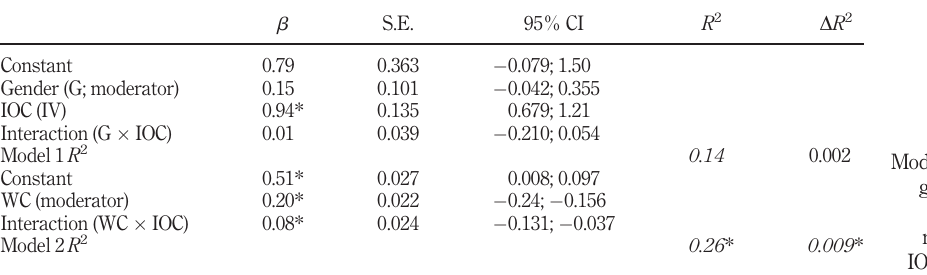
Table 5. Moderating effect of